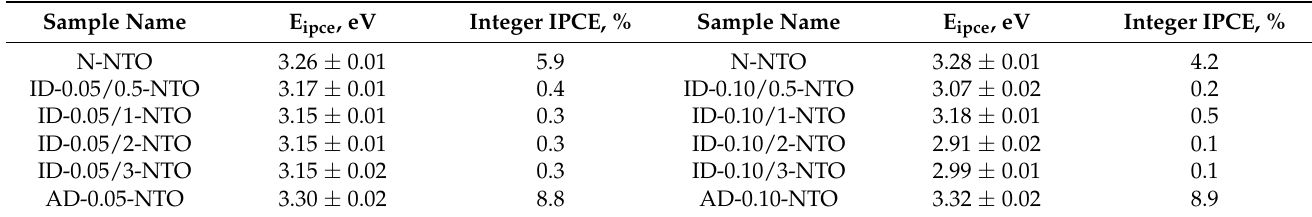
Table 2. Calculated conversion bandgap and integer IPCE of Ni-doped